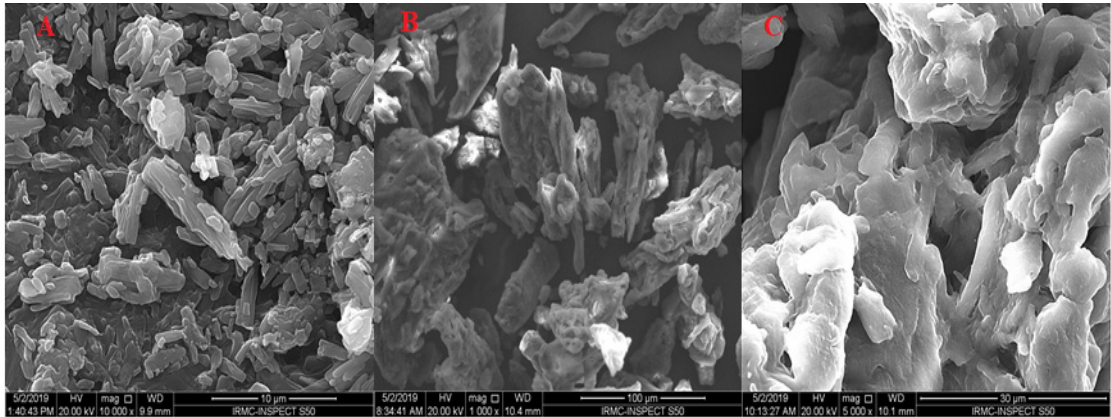
Figure 6. SEM image of ( A ) pure PE, ( B ) Avicel PH101, and ( C ) S-PE - SNEDDS (SOF3).